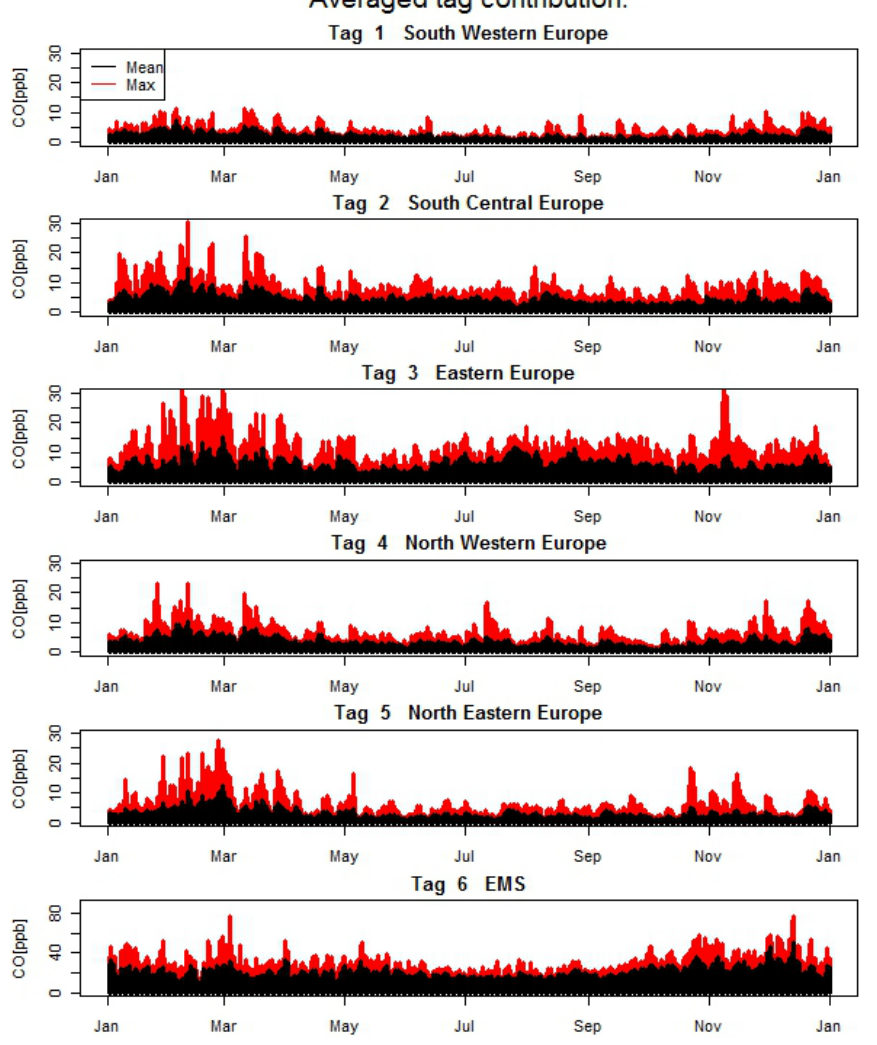
Fig. 13. Average (black) and maximum (red) tag contribution for the study period for Sde-Boker (2003–2007). Major episodes can be seen during winter months for all tags. Enhancement is for tag 3 during